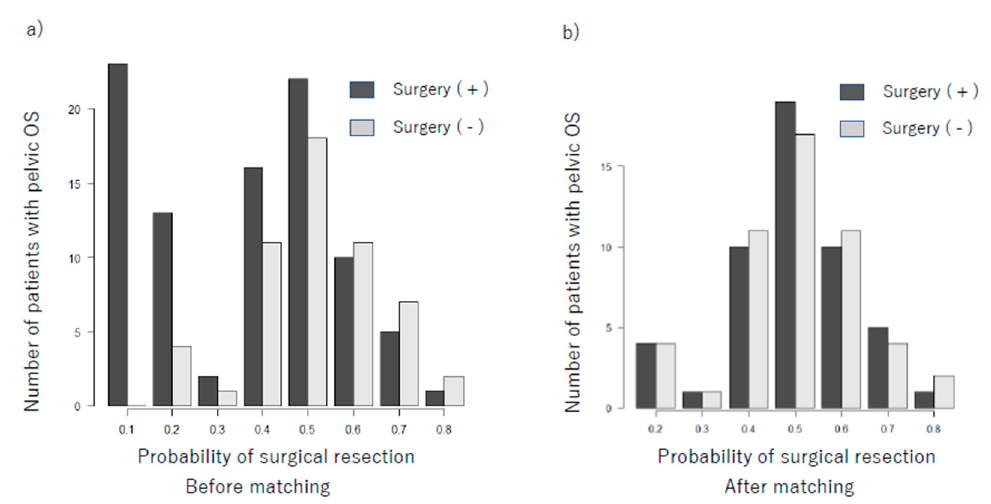
Figure 3. The imbalances of the propensity score (defined as the probability of undergoing surgical resection of the primary tumor in pelvic osteosarcoma) were diminished after propensity score matching. ( a ) Before propensity score matching ( b ) after propensity score matching.